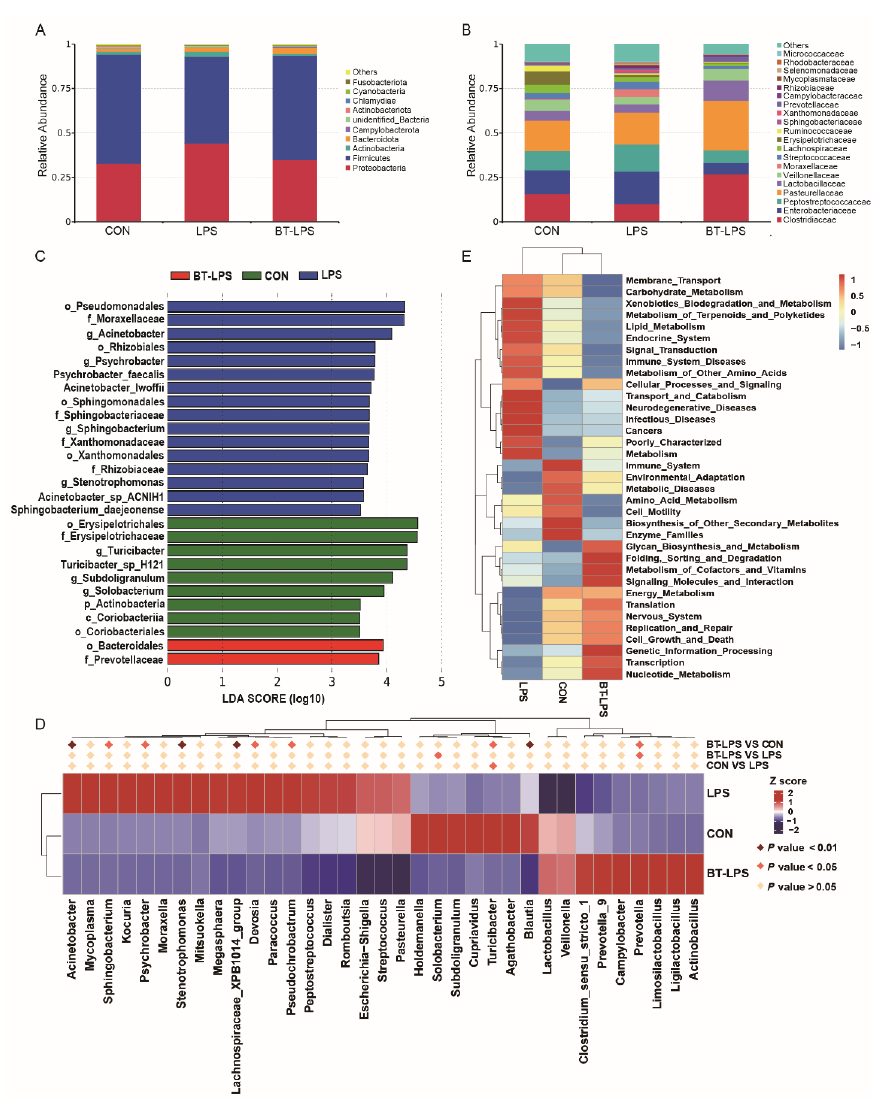
Figure 4. The effects of butyrate on bacterial compositions in LPS-induced jejunum. ( A , B ) Distribution of jejunal bacteria at phylum and family levels. ( C ) Taxa enrichment based on LEfSe analysis identified significant microbial community differences between groups. A logarithmic LDA score > 3.5 was selected. ( D ) Metastat was used to test for significant differences between the top 35 genera relative abundance; dark pink diamonds indicate p < 0.01, and deep pink diamonds indicate p < 0.05 differences between two groups. ( E ) The top 35 predicted metabolism pathways based on KEGG II levels from PICRUSt analysis. Values are the mean ± standard error ( n = 6).